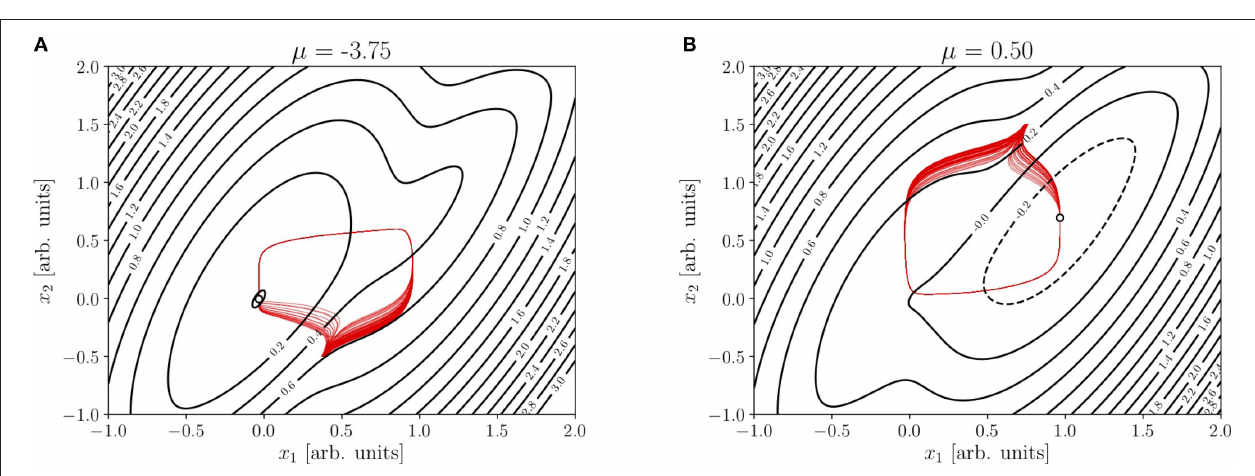
FIGURE 3 | (A,B) Contour plot of the NEP in Figures 2C,D , together with trajectories (in red) from random initial conditions within suitably selected tiny patches. Parameters: ρ